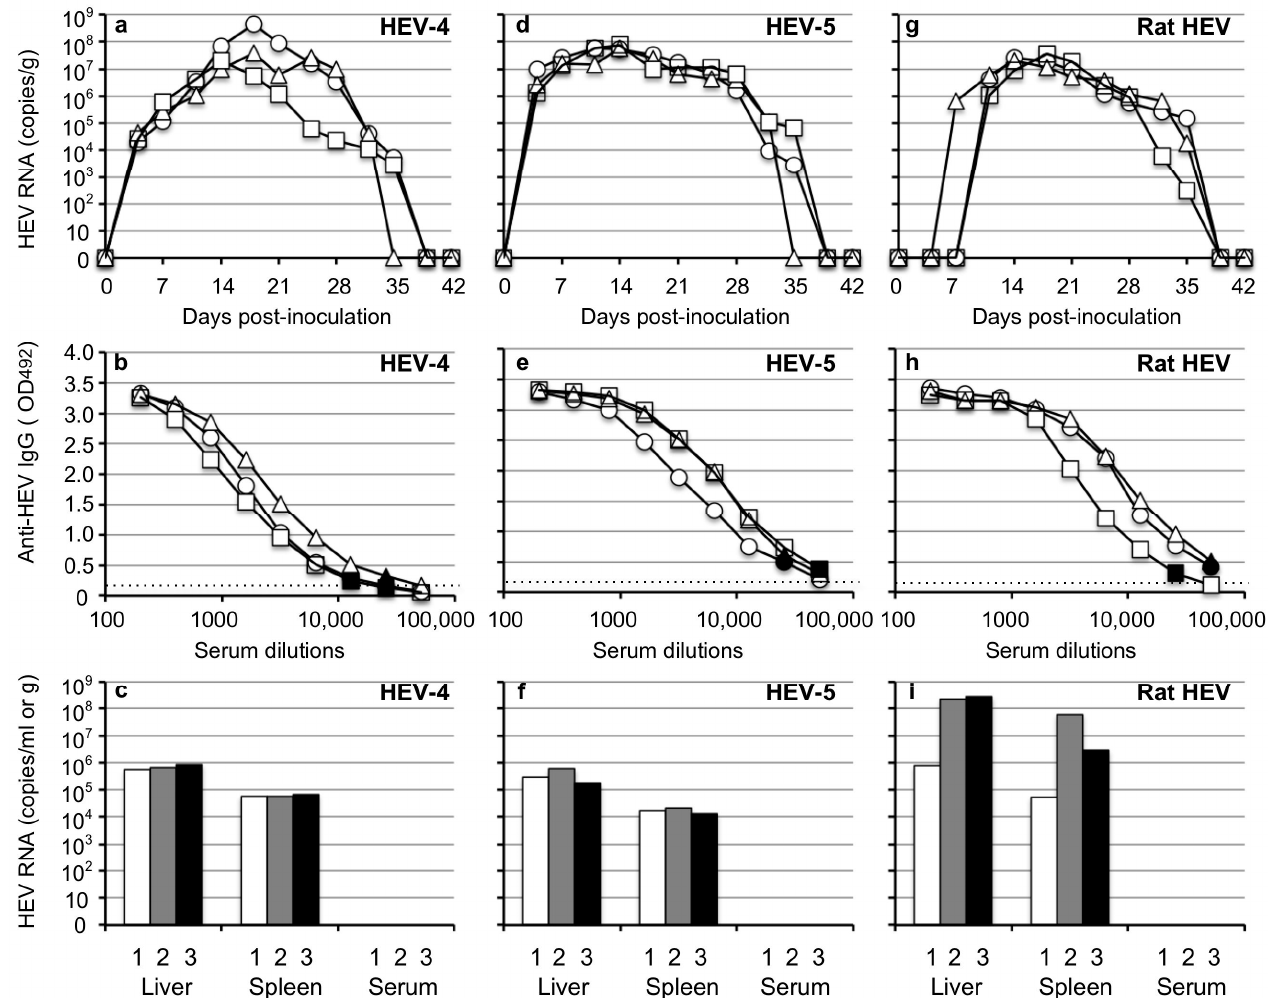
Figure 2. Infectivity of HEV discharged into the feces. Three groups of Mongolia gerbils ( n = 3 per group) were inoculated with the 10% stool suspension prepared from the HEV-4-inoculated, HEV-5-inoculated or rat HEV-inoculated gerbils. Individual gerbils are indicated by , (cid:52) and (cid:3) ( a , b , d , e , g , h ) or white, gray and black bars ( c , f , i ). The kinetics of the viral RNA in the fecal specimens were determined by RT-qPCR ( a , d , g ). The serum and tissue samples were collected at the end of the experiment (day 42 p.i.). The serum anti-HEV IgG antibodies were measured using an ELISA with either VLPs of HEV-1 (to detect HEV-4 and HEV-5) or those of rat HEV (to detect rat HEV) as the antigens. Dotted lines: the cut-off values and the minimum endpoints of the antibody titers are blackened ( • , (cid:78) , (cid:4) ) ( b , e , h ). The viral RNA titers detected in the liver, spleen and serum ( c,f,i ). Serum anti-HEV IgG antibodies were detected in all HEV-4-, HEV-5- and rat HEV- inoculated animals, and the antibody titers of other animals collected on day 42 p.i. were higher than 1:12,800 (Figure